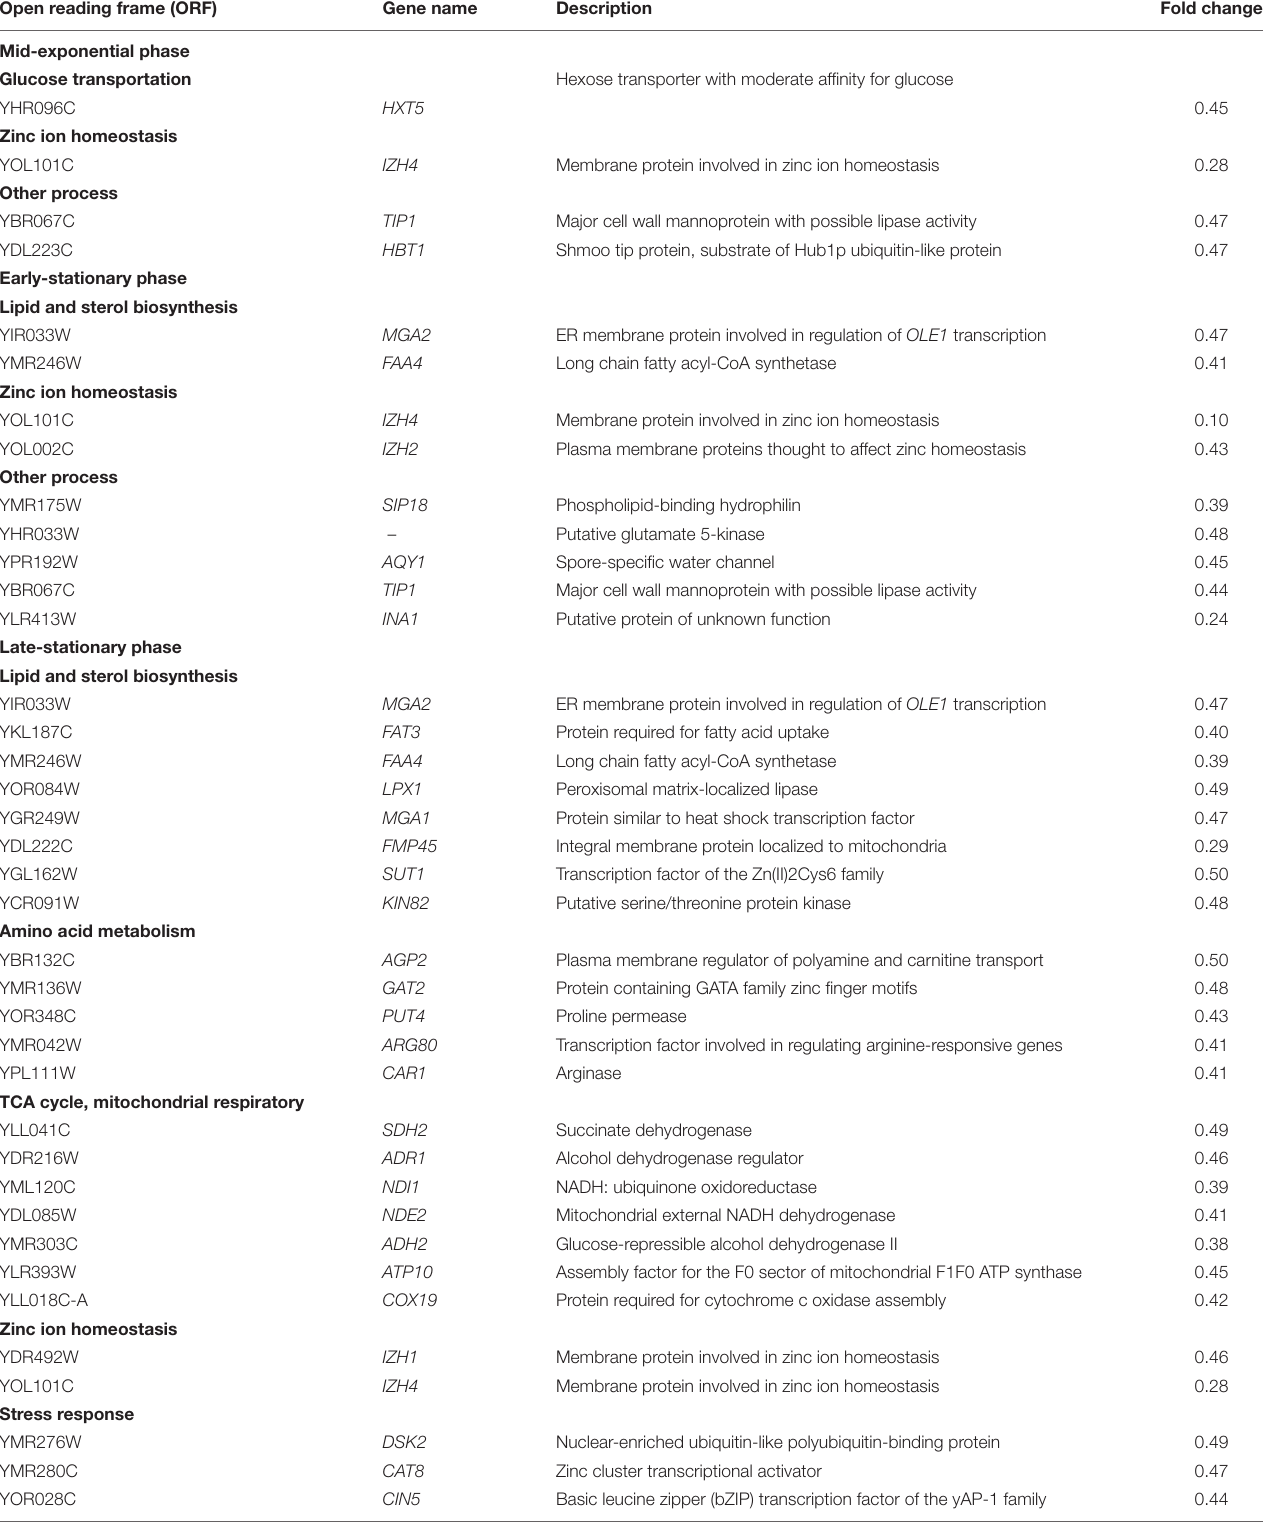
TABLE 3 | Genes downregulated in MS300 media with high vs. low concentrations of UFAs, in different stages of yeast growth categorized by biological process (double or more). Open reading frame